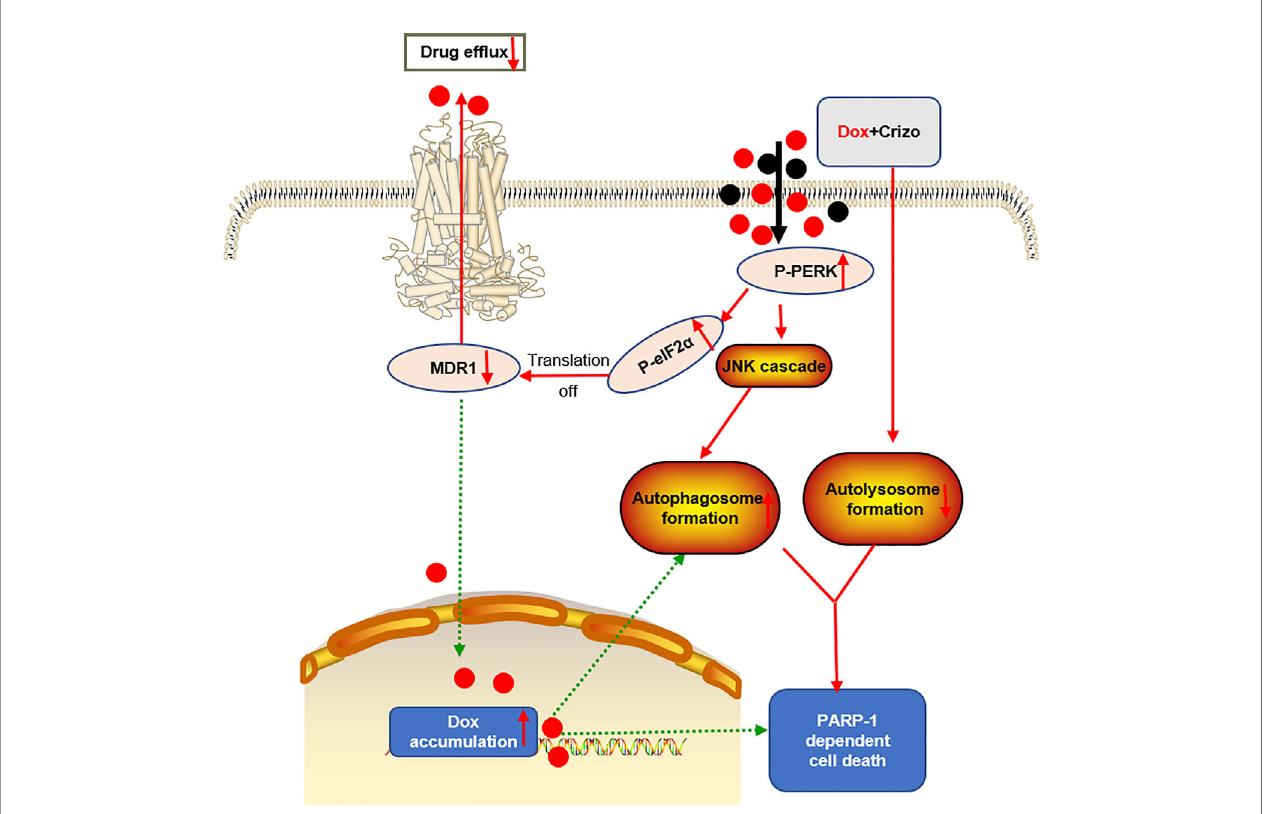
FIGURE 8 | A proposed model to show how Dox plus Crizo act synergistically in killing HCC cells. Crizo plus Dox actiate PERK, which in turn phosphorylates eIF2 a , leading to protein translation repression. As a consequence, MDR1 protein level Is reduced, resulting in nuclei accumulation of Dox and DNA damage. In addition, activation of PERK also phosphorylates JNK, leading to autophagosome formation. Somehow, Crizo plus Dox also suppress the fusion between autophagosome and lysosome. All of the mentioned effects cause PARP-1 dependent HCC cell